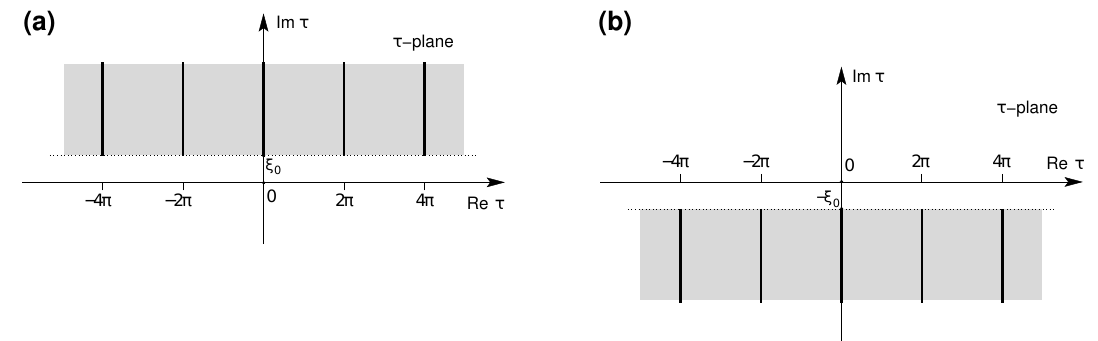
( ξ 0 ) \ τ Ξ ( ξ 0 ) + + , ( b ) the = 2 k π , k ∈ Z